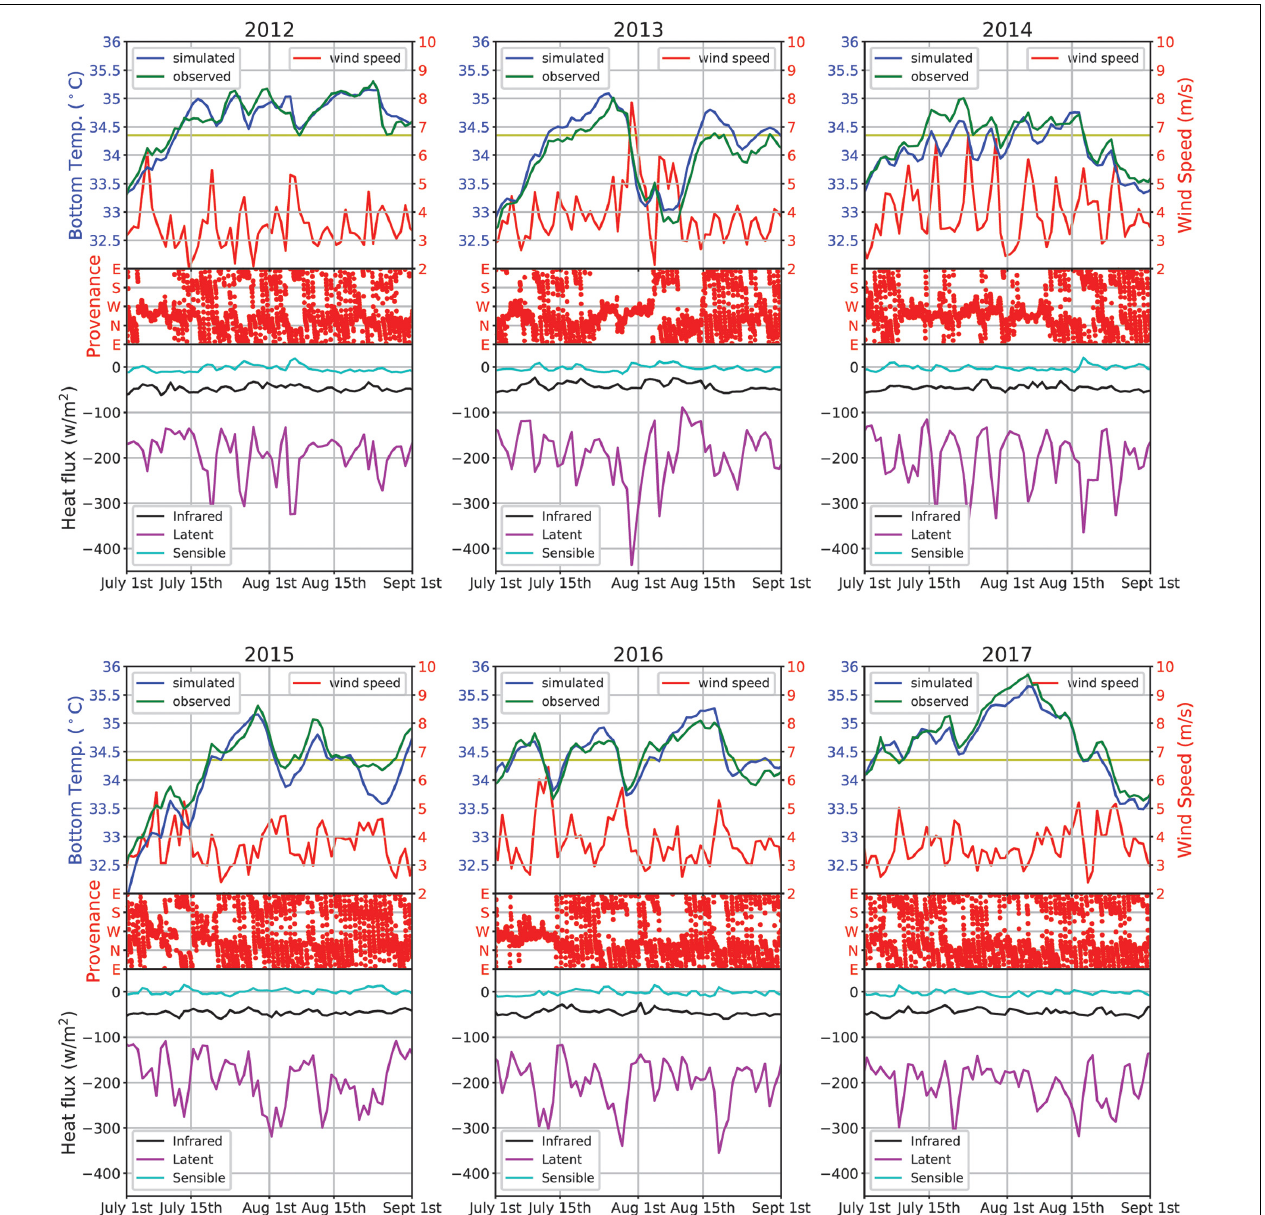
FIGURE 4 | Sea-bottom temperature, wind speed and direction and sea-surface heat fluxes in July and August 2012 to 2017 at Saadiyat reef. Top panels: simulated (blue) and observed (green) daily averaged bottom temperature (left scale) and daily averaged wind speed (right scale); the level corresponding to the 34.35 ◦ C coral bleaching threshold has been highlighted for visual reference. Mid panels: hourly direction from which the wind blows. Bottom panels: daily averaged sensible (cyan), infrared (black), and latent (purple) heat fluxes at the sea